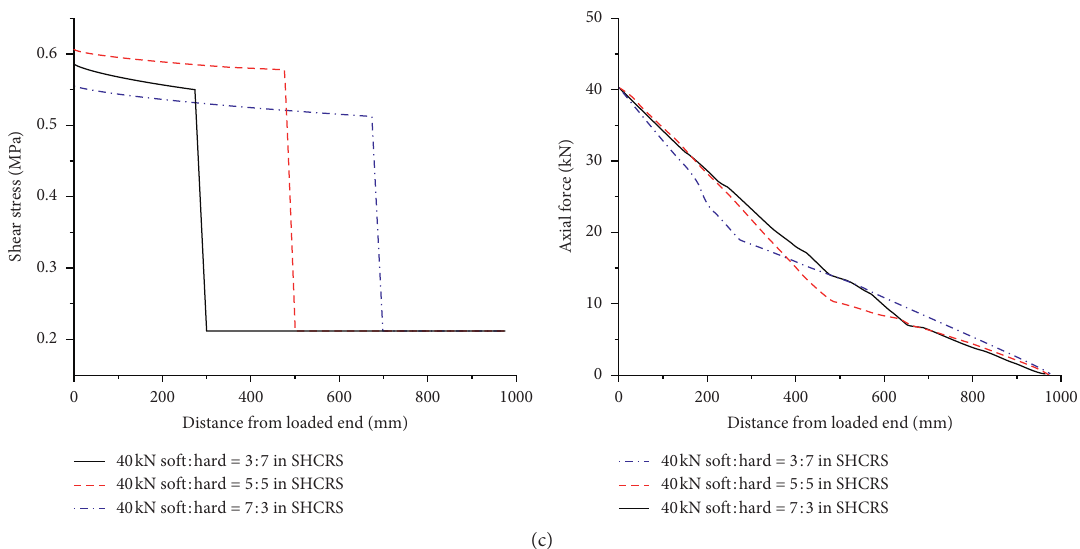
Figure 15: Shear stress (left) and axial force (right) distribution curves of soft-to-hard thickness ratios (7:3, 5 :5, 3:7) in SHCRS. (a) Linear stage. (b) Nonlinear stage. (c) Softening and debonding